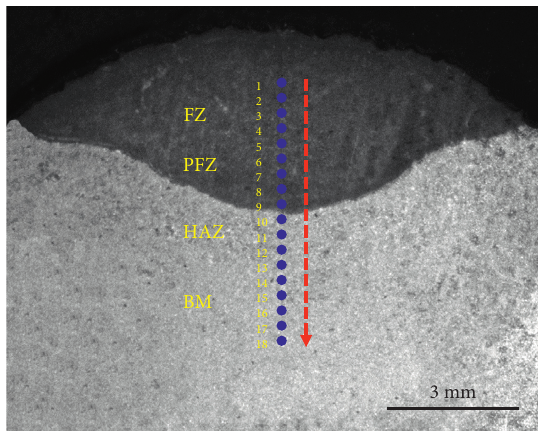
Figure 3: Microhardness mapping along the fusion zone (FZ), partial fusion zone (PFZ), heat-affected zone (HAZ), and base material (BM) of a typical weld prepared by the AW-LSF (welding current of 130A, welding speed of 160mm/min, and laser shock frequency of